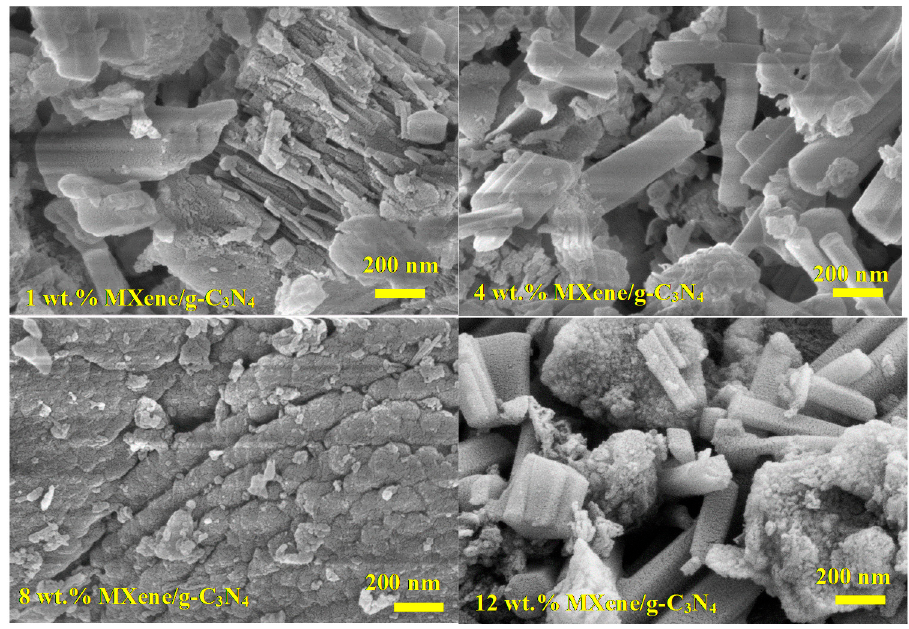
Figure 4. FESEM images of the as-synthesized MXene/g-C 3 N 4 heterostructure photocatalysts.